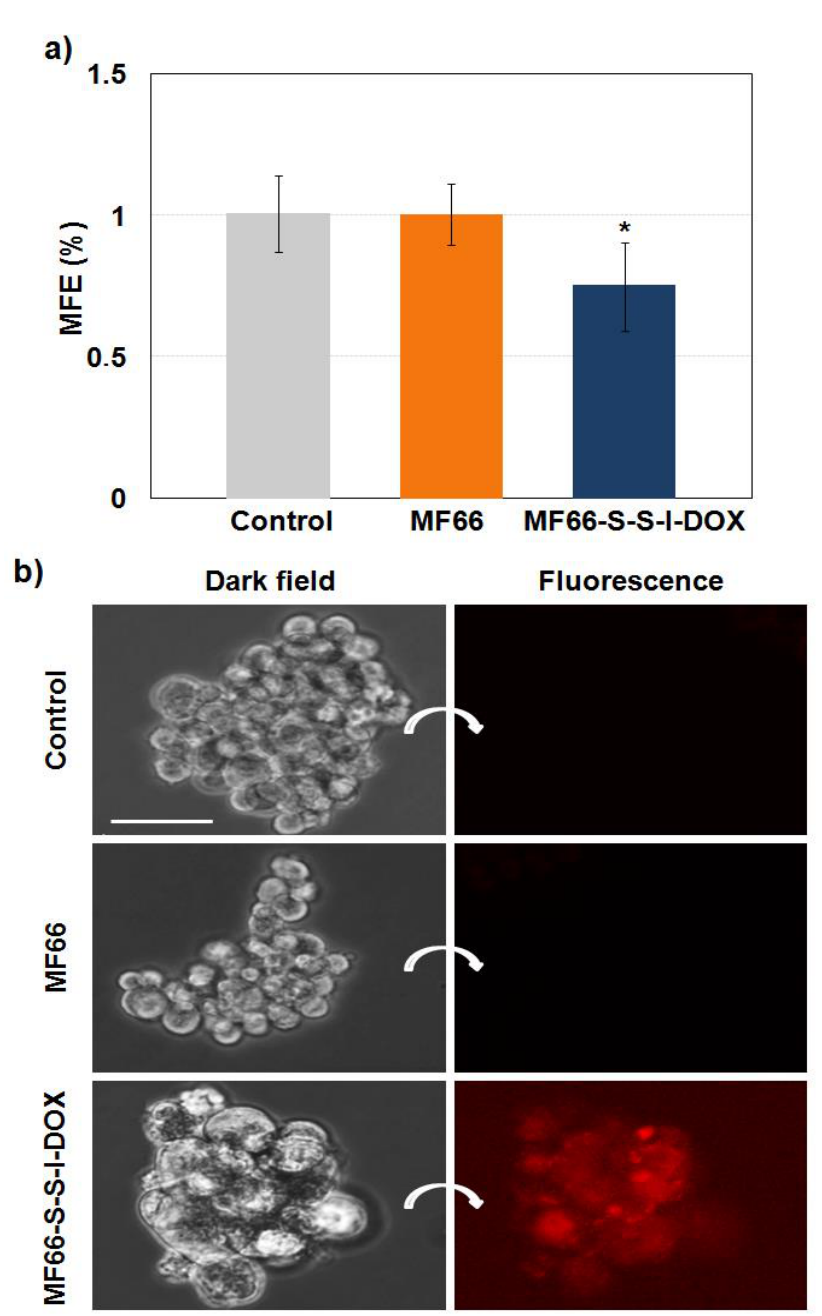
Figure 6. Mammospheres from MDA-MB-231 cells untreated (control) or treated with MF66 and MF66-S-S-I-DOX. ( a ) Quantification of mammosphere forming e ffi ciency analysed 5 days after cell 24 h incubation with magnetic nanoparticles (MNPs). ( b ) Images of mammospheres in phase contrast and fluorescence microscopy 72 h after mammosphere formation assay. Scale bar: 50 µ